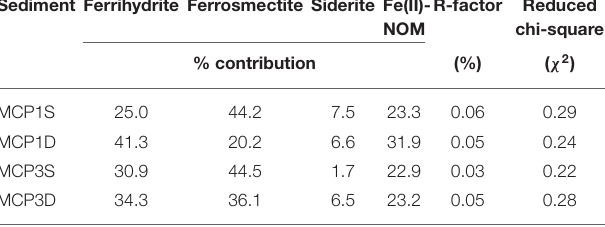
TABLE 3 | Linear combination fit (LCF) analysis results for Fe K-edge EXAFS spectra of sediment samples collected from MCP1 and MCP3 wells at shallow (S) and deep (D)